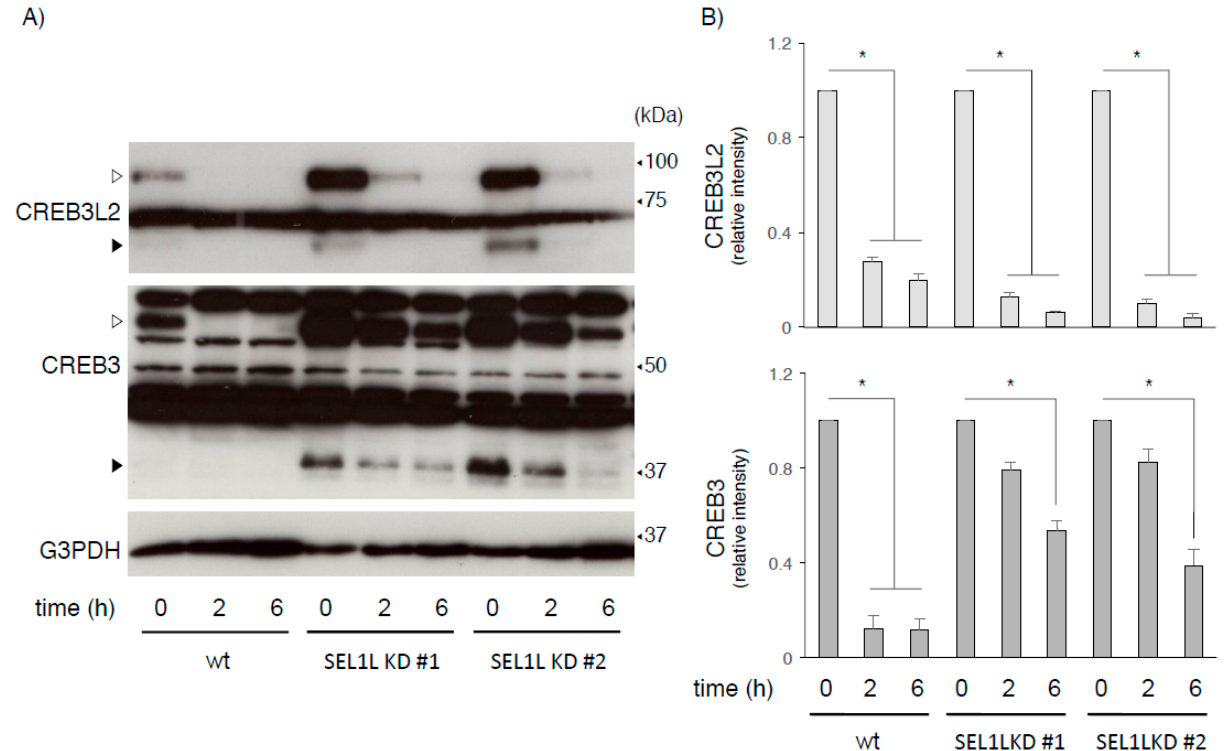
Figure 3. Comparison of the stability of the CREB3 and CREB3L2 proteins in HEK293 cells. ( A ) Wild-type (wt) and SEL1L-deficient HEK293 cells were treated with CHX (20 µ g/mL) for the indicated times. The expression of the indicated proteins in wt and SEL1L-deficient cells was detected. Open and filled arrowheads indicate full-length mature and cleaved CREB3 and CREB3L2 proteins, respectively. Representative results of three independent cultures are shown. ( B ) The relative amounts of full-length CREB3 and CREB3L2 in wt and SEL1L-deficient cells were evaluated as described in the Materials and Methods. The amount of each protein in wt and SEL1L-deficient cells without CHX treatment was considered “1”. Each value represents the mean ± SEM from three independent cultures. Values marked with asterisks are significantly different between the indicated groups (* p <